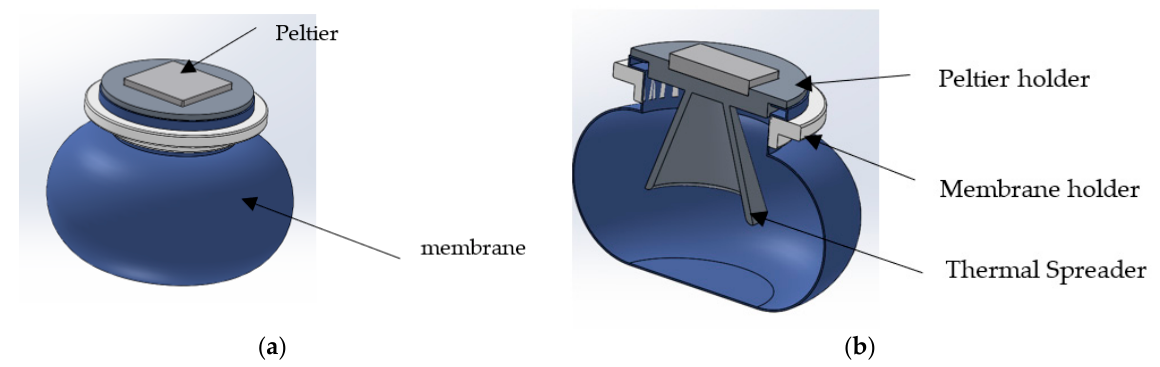
Figure 2. Demonstration of concept showing the picking up of different objects using a party balloon semi-filled with coconut oil frozen around the object to be picked up.